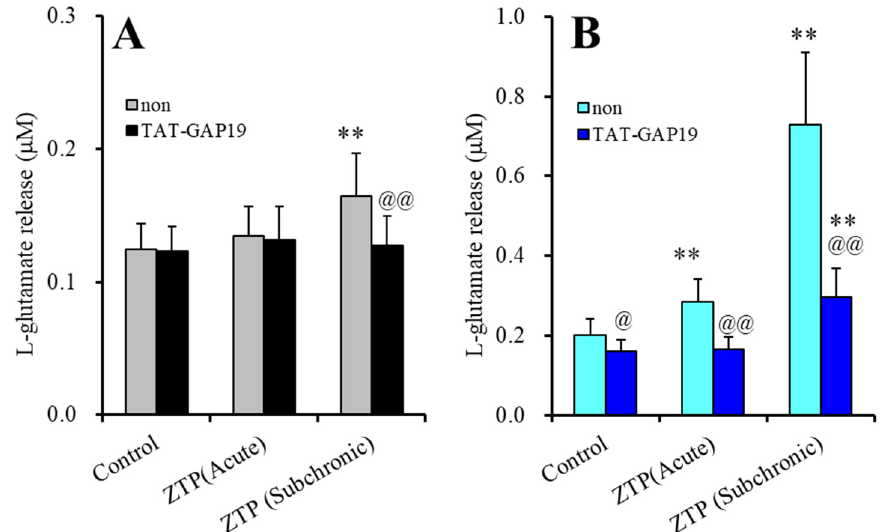
Figure 2. Effects of selective Cx43 inhibitor, N-terminal transactivator of transcription GAP19 (TAT- GAP19) (10 µ M) on stimulatory effects of supratherapeutic concentration of ZTP (1000 nM) on basal ( A ) and HK-ACSF-evoked ( B ) astroglial L-glutamate releases. Ordinate: mean ± SD (n = 6) of astroglial L-glutamate release ( µ M). Light and dark colour columns indicate the incubation without (non) and with TAT-GAP19, respectively. ** p < 0.01: relative to non, @ p < 0.05, @@ p < 0.01